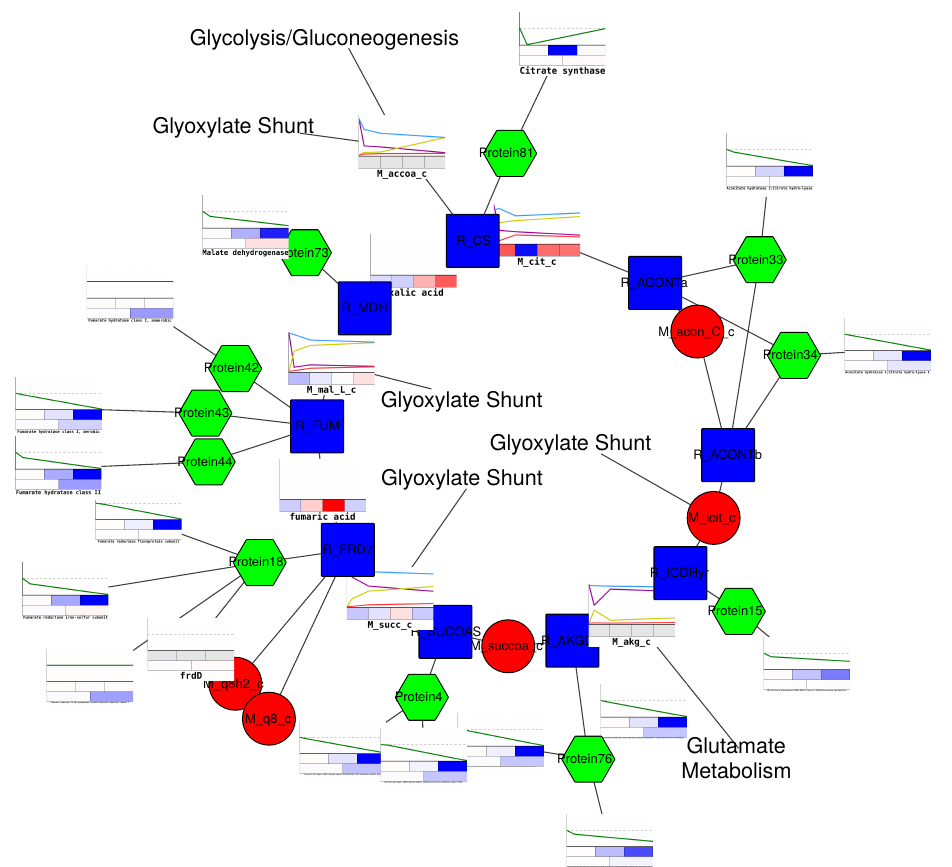
Figure 4. E. coli TCA (tricarboxylic acid cycle) with data mapped from multiple sources. Labeling data suggest usage of the glyoxylate shunt, as alphaketoglutarate is the only metabolite not accumulating labeling. Overall expression and protein levels are lower, but metabolite levels seem to increase upon treatment. Red circles represent metabolites, green hexagons represent proteins formed by the genes accoring to the GPR rules from the sbml. Blue squares represent